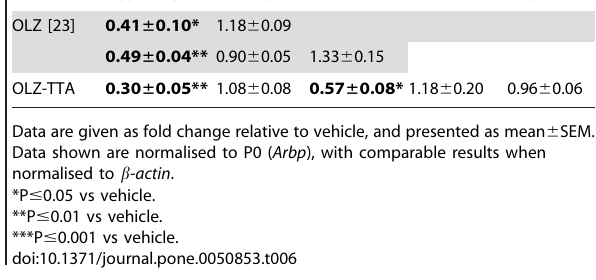
Data are given as fold change relative to vehicle, and presented as mean 6 SEM. Data shown are normalised to P0 ( Arbp ), with comparable results when normalised to b -actin . *P # 0.05 vs